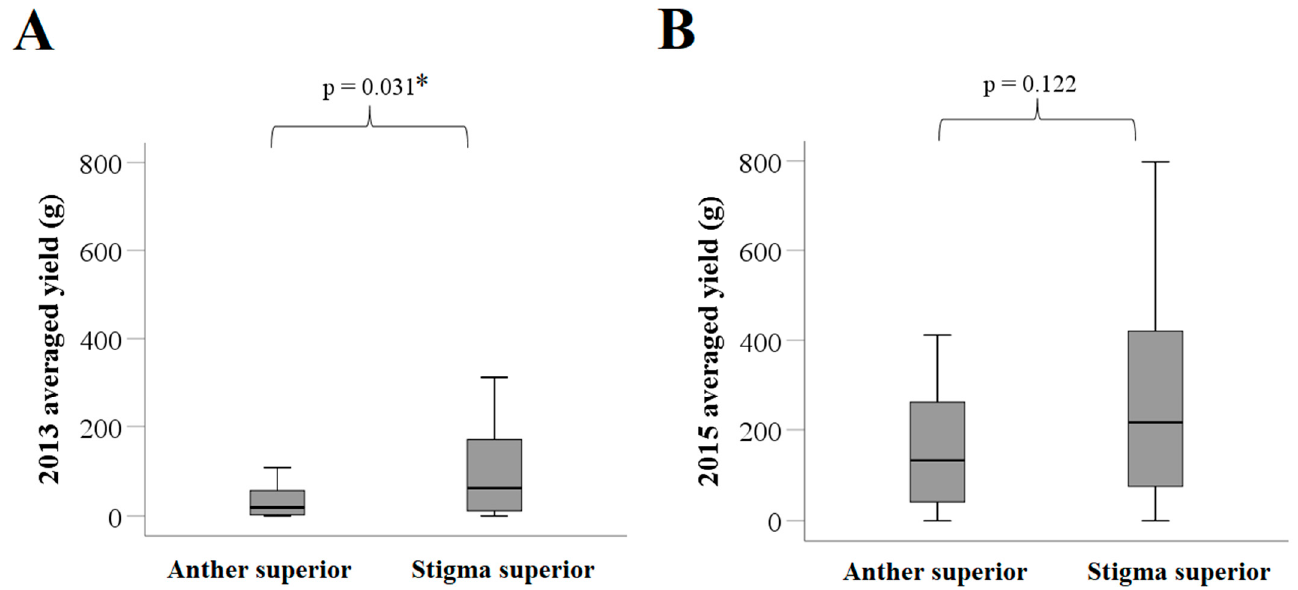
Figure 5. Distribution of fruit yields between the anther and stigma superior groups of the tea varieties. ( A ) Fruit yield distribution in 2013; and ( B ) fruit yield distribution in 2015. The p -values in the figure were obtained based on the non-parametric Mann– Whitney test. * p < 0.05 indicates that the difference between the groups was statistically significant.